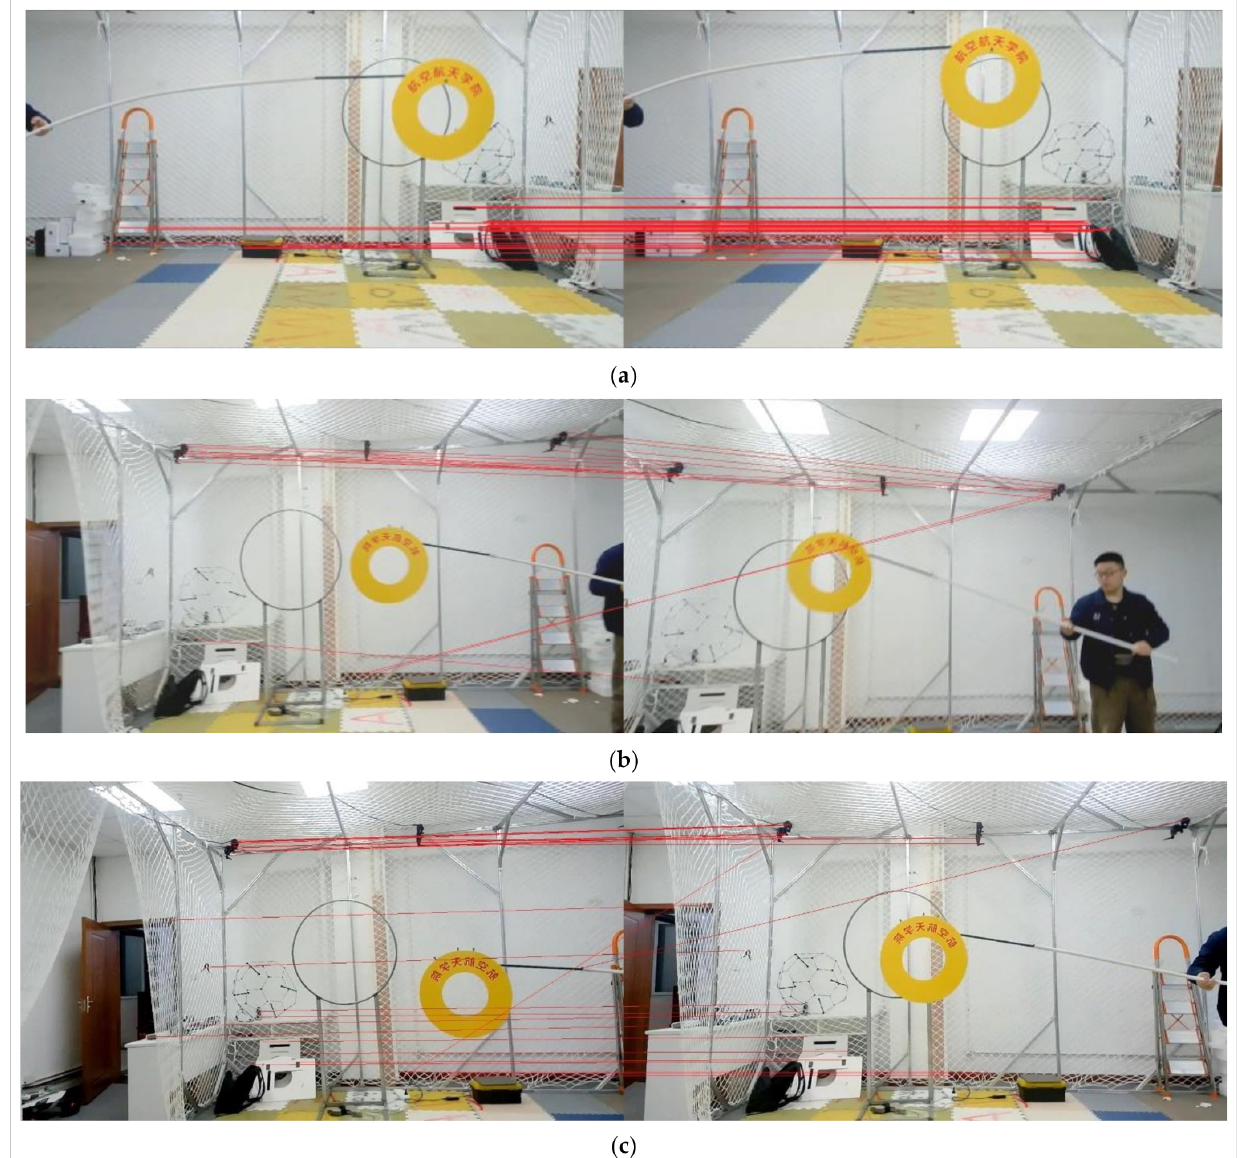
Figure 14. The schematic diagram of randomly extracting orb feature point matching: ( a – c ) is the orb feature points matching between two pairs of